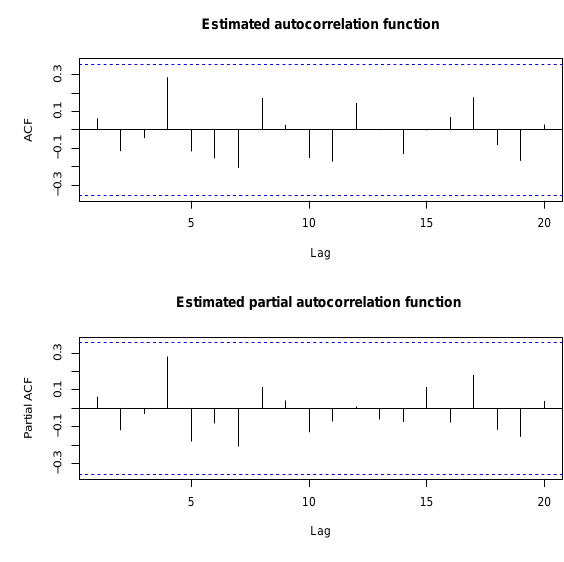
Figure 4 – Estimated OR TaT autocorrelation and partial autocorrelation